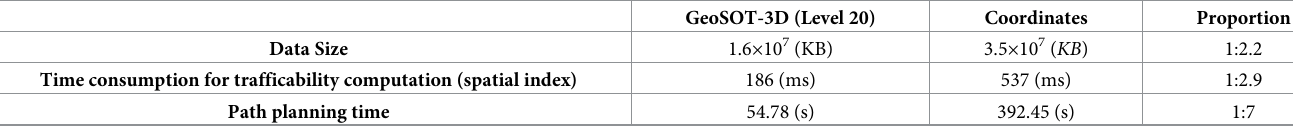
Table 2. Airspace performance comparison between coordinates and GeoSOT-3D at the 20th